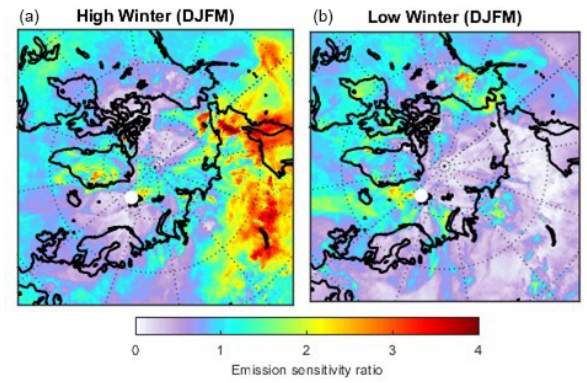
Figure 17. The ratio of the hexachlorobenzene (HCB) emission sensitivities to the average at the Zeppelin Observatory during a ) high levels ( > 80th percentile) and b ) low levels ( < 20th percentile) during the Arctic haze period (March to December) in 2014 to 2017. This ratio yields a qualitative description of source regions of HCB with red indicating the source regions contributing most to high HCB levels in (a) and to low HCB levels in (b)